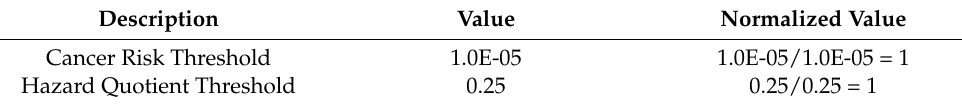
Table 5. Target Risk Levels.